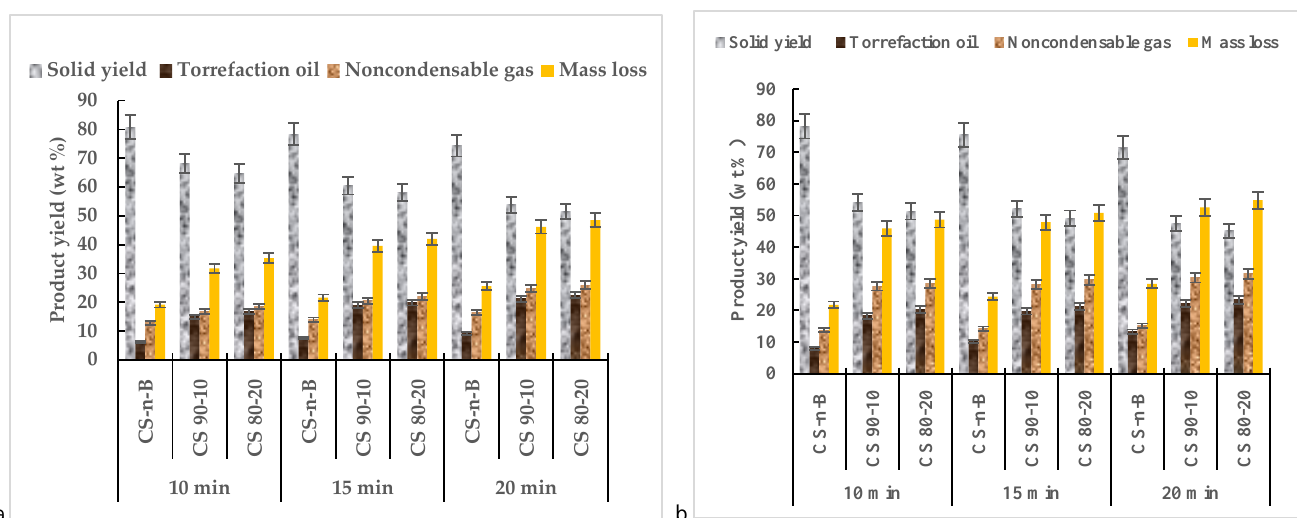
Figure 4. Fraction yields and mass losses of microwave torrefied camelina straw-biochar-mix at ( a ) 520 W and ( b ) 650 W. CS: camelina straw; CS-n-B: camelina straw-no-biochar. The first number after the biomass is % of biomass, and the second number is % of biochar.